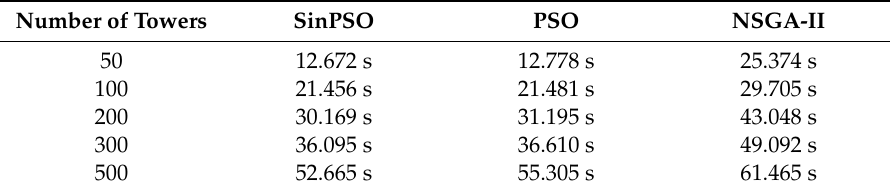
Table 5. Algorithm running time.